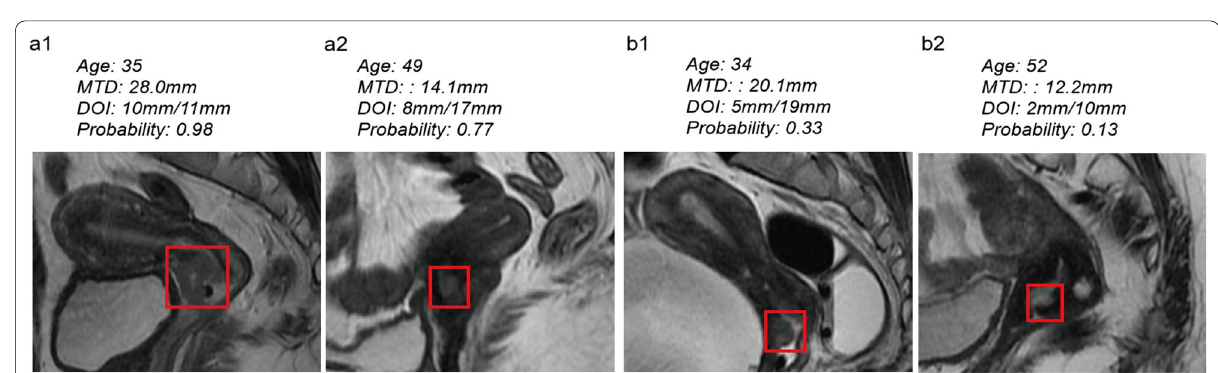
Fig. 5 Representative images of middle or deep cervical stroma invasion ( a ) and superficial cervical stroma invasion ( b ). The lesions in the frames on sagittal T2WI are cervical tumors. a1 a 35‑year‑old, 2018 FIGO IB2, SCC patient with MTD on MRI of 28.0 mm. The probability of the middle or deep stroma invasion predicted by the nomogram was 98%. a2 a 49‑year‑old, 2018 FIGO IB1, SCC patient with MTD on MRI of 14.1 mm. The probability of the middle or deep stroma invasion predicted by the nomogram was 77%. b1 a 34‑year‑old, 2018 FIGO IB2, SCC patient with MTD on MRI of 20.1 mm. The probability of the middle or deep stroma invasion predicted by the nomogram was 33%. b2 a 52‑year‑old, 2018 FIGO IB1, AC patient with MTD on MRI of 12.2 mm. The probability of the middle or deep stroma invasion predicted by the nomogram was 13%. (MTD: maximal tumor diameter; FIGO: Federation International of Gynecology and Obstetrics; SCC: squamous cell carcinoma; AC: